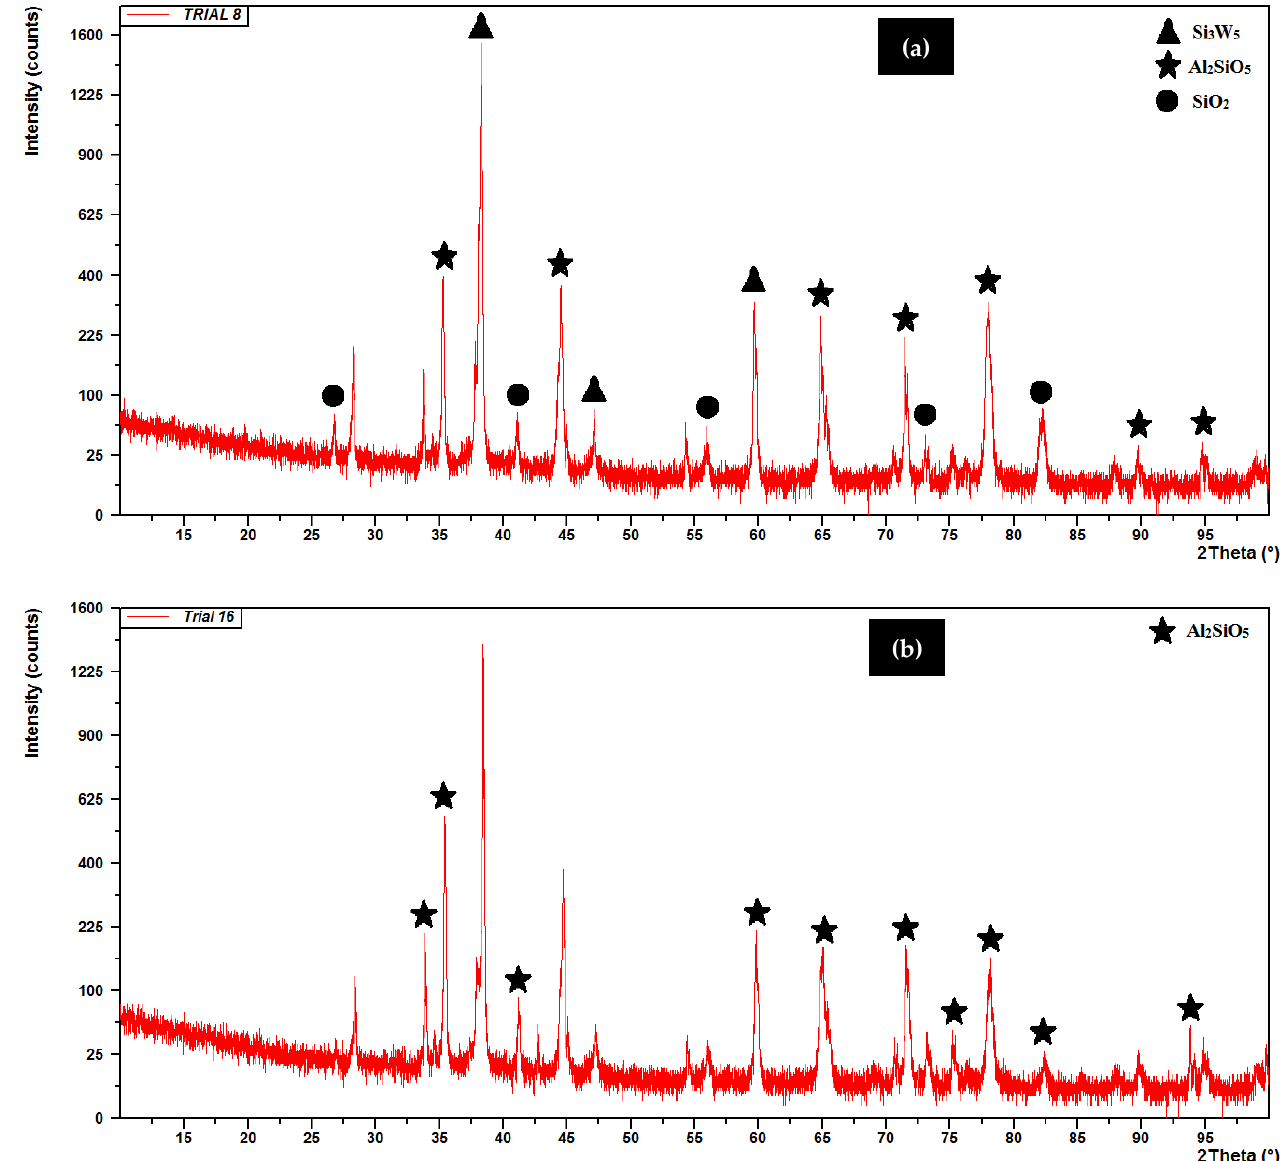
Figure 7. X-ray diffraction of ( a ) Trial 8 and ( b ) Trial 16.